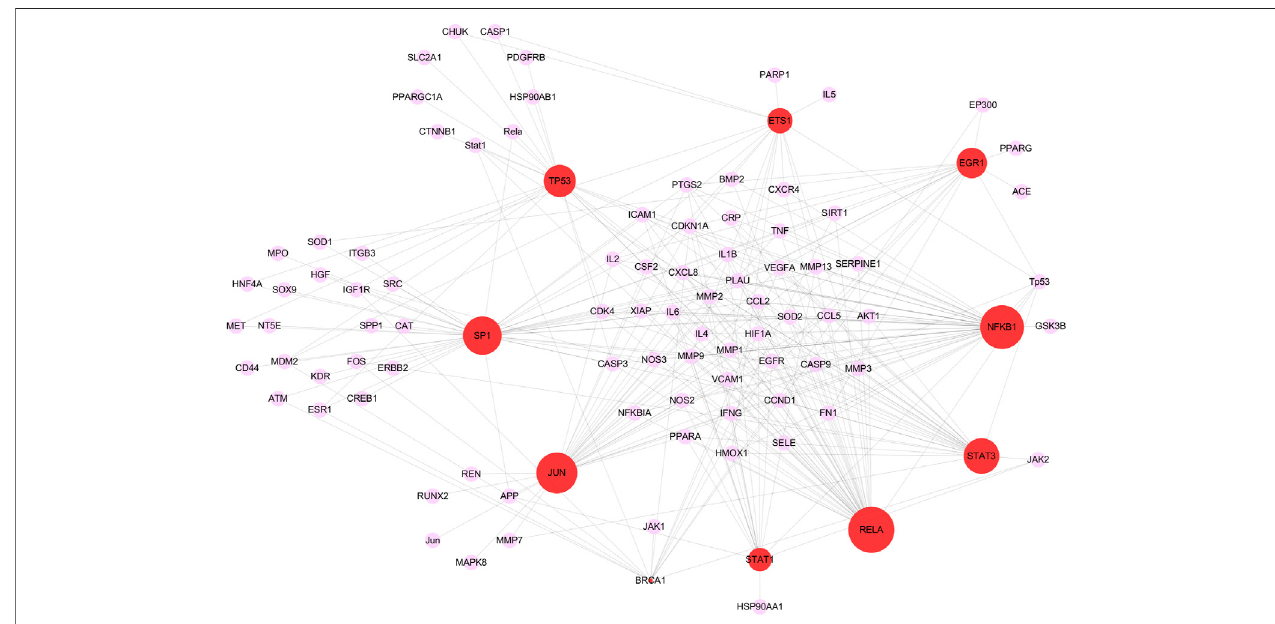
FIGURE 5 | The top 10 key transcription factors (TFs) of 115 critical targets. The red nodes represent TFs and the purple nodes represent corresponding targets. TheedgesrepresenttheconnectionbetweenTFsandtargets.Thesizesofrednodespresentnegativecorrelationwith p valuesandanodewithlargershaperepresents the more important role in treating COVID-19/pulmonary fi brosis co-occurrence.